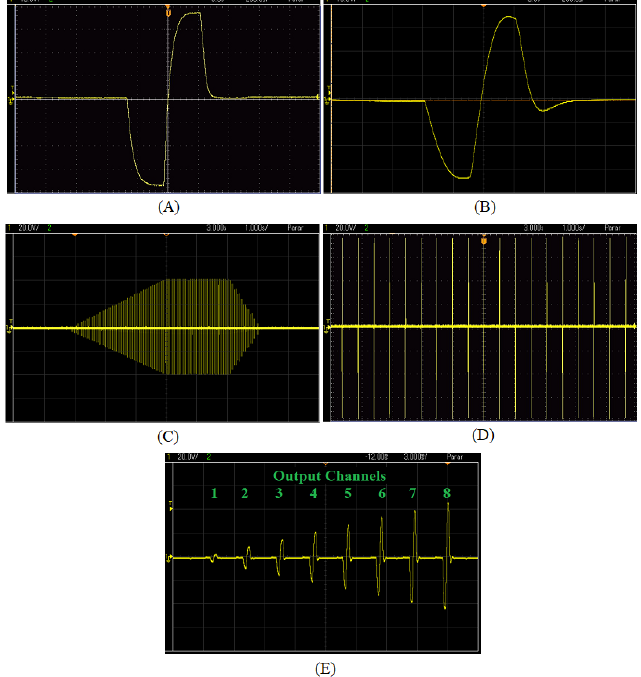
Figure 10. STIMGRASP output signal. ( A ) Output biphasic pulse with resistive load; ( B ) output biphasic pulse with RC load; ( C ) pulse train in a channel with upward and downward ramps; ( D ) pulse train in a channel; ( E ) eight multiplexed output